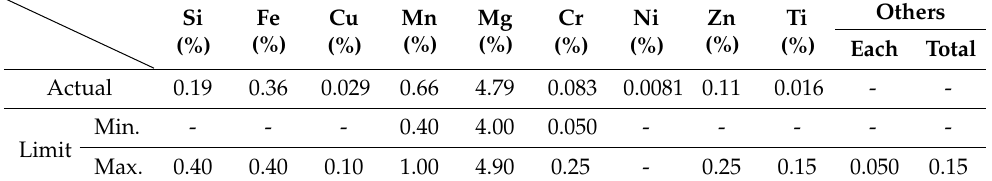
Table 5. Chemical composition of Al 5083 H321.